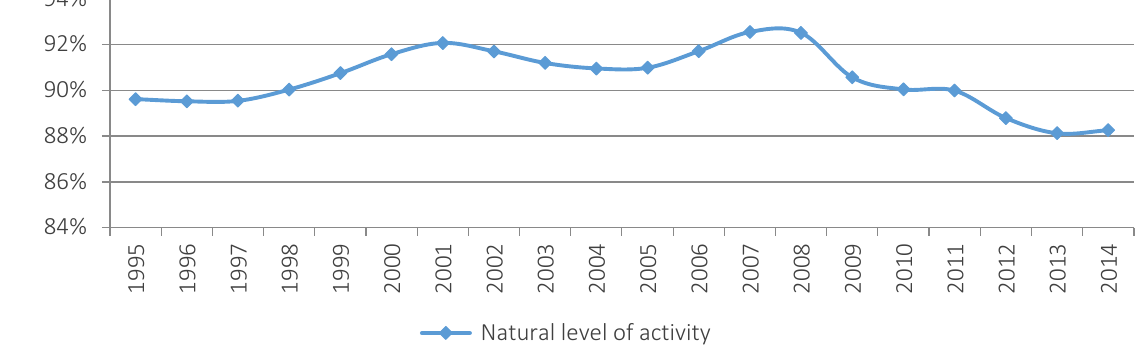
Figure 3. The natural level of employment for the countries of the